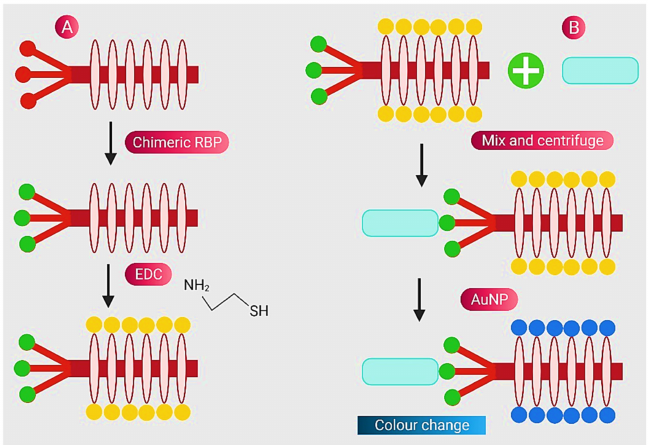
Figure 1. Schematic representation for chimeric phages and detection of pathogens ( A ) Gray: M13 phage, blue: foreign receptor-binding protein and yellow: thiolated phage by EDC chemistry ( B ) Blue rectangle: bacteria-infected medium, red: Au NPs and colour change (purple): attachment of Au NPs and thiolated phage. Reprinted from Ref.